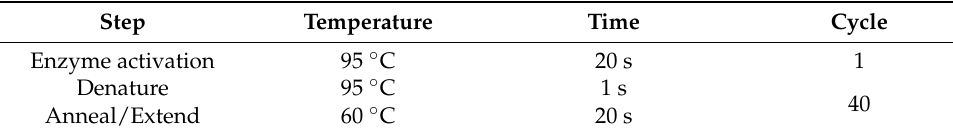
Table 2. qRT-PCR conditions—TaqMan™ Fast Advanced Master Mix (miRNA detection).